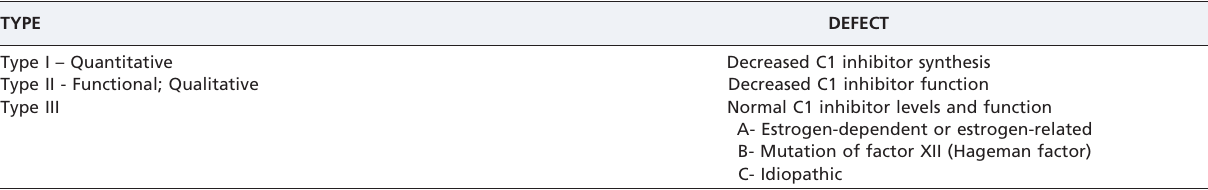
Table 1 - Classification of hereditary angioedema.